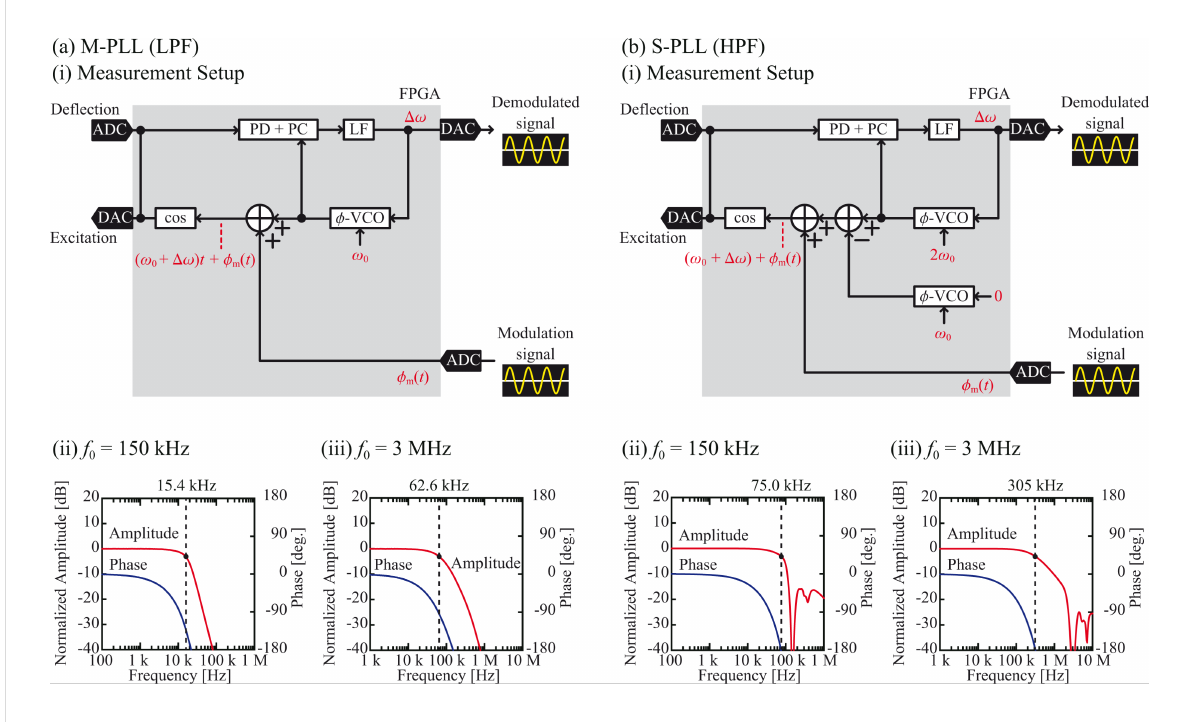
Figure 5: Performances of the (a) M-PLL with the LPF and (b) S-PLL with the HPF. (i) Block diagrams of the measurement setups. Frequency responses of the PLLs with (ii) f 0 = 150 kHz and (iii) f 0 = 3 MHz.